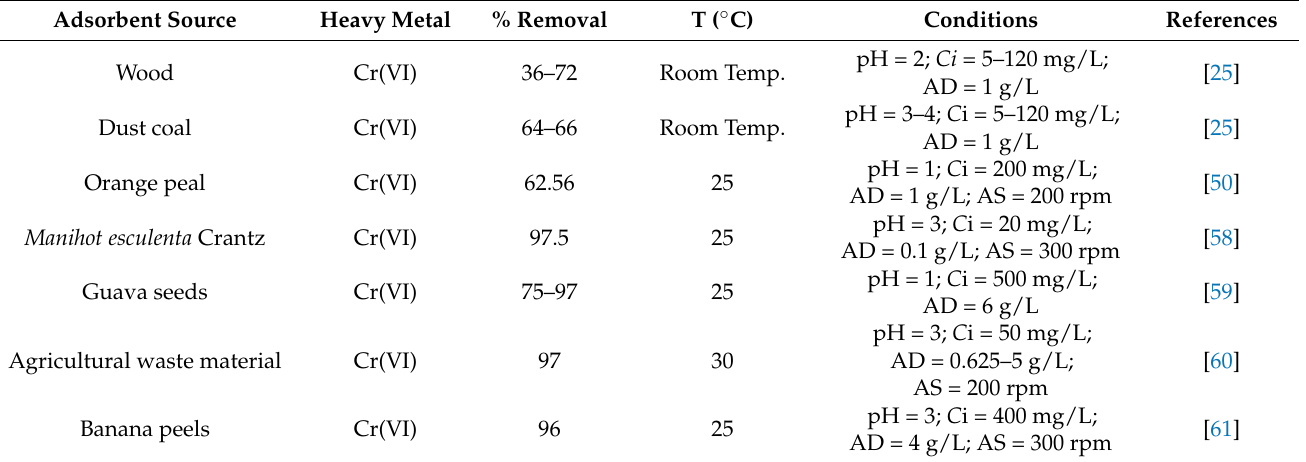
Table 5. Comparison of adsorption efficiency (% removal) for Cr(VI) and Pb(II) using other adsorbents and the adsorbent used in this study. C i = the initial concentration of the metal ions; AD = adsorbent dose; AS = agitation